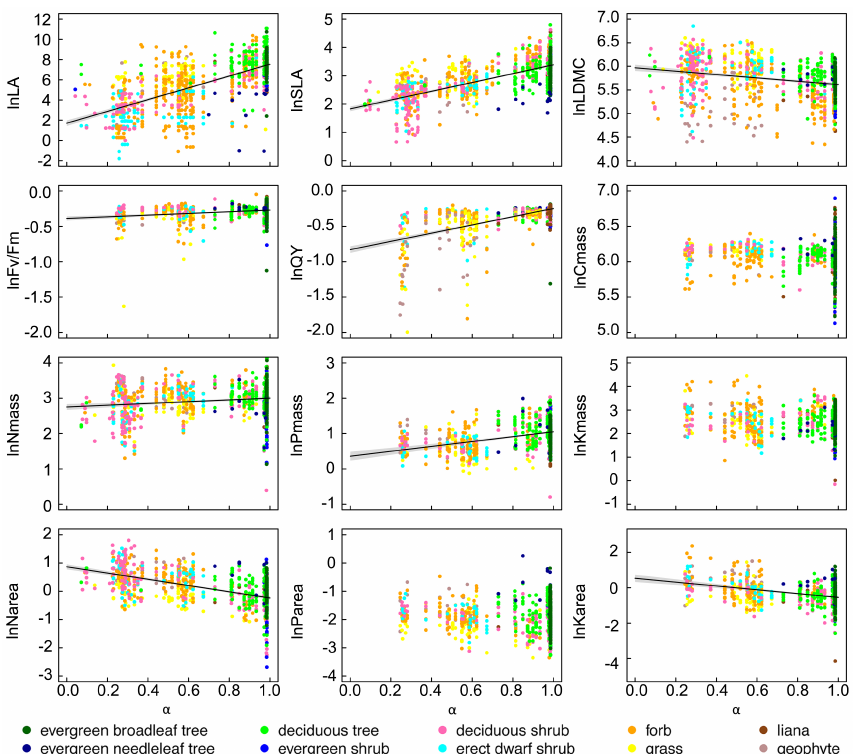
Figure 3. Partial residual plots for the relationships between leaf traits and the Cramer-Prentice moisture index ( α) , from the GLM analysis summarised in Table 2. Each point denotes a species-site combination; PFTs are indicated by colours. Only significant regression slopes ( P <0.01) are